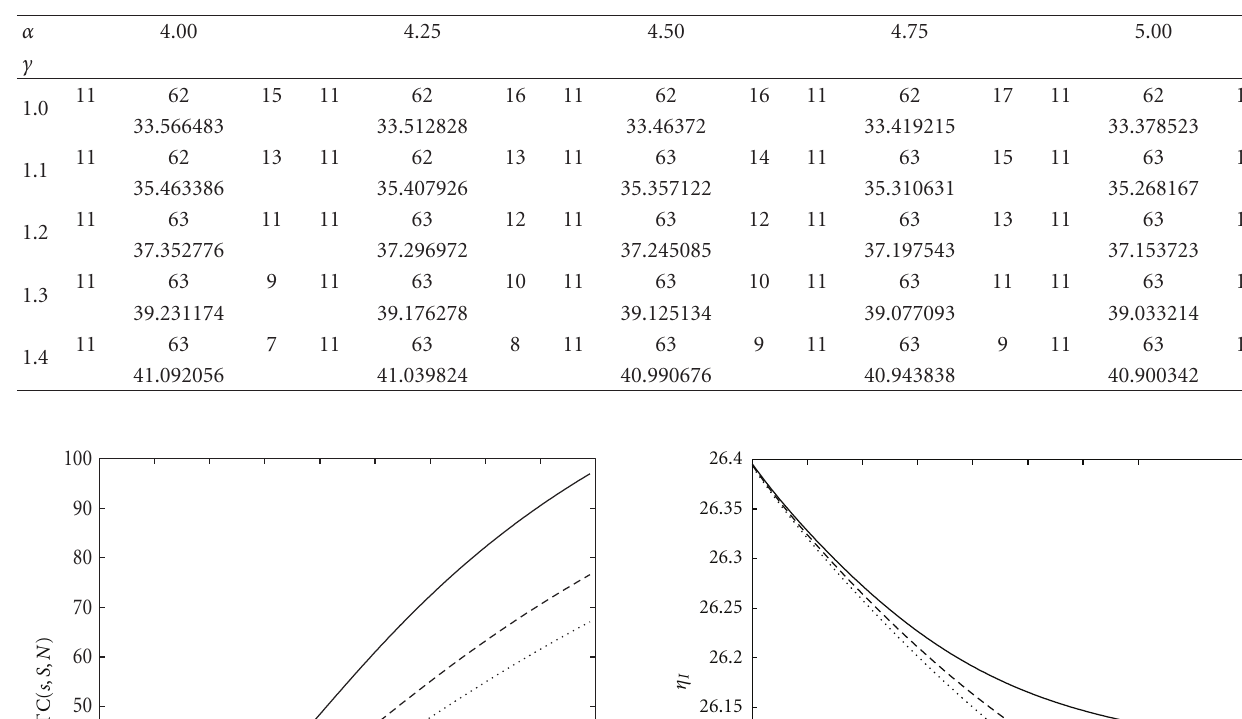
Table 10: Optimal values corresponding to various perishable rates and postponed demand rates ( λ = 14, β = 1 . 3, μ = 4, p = 0 . 85).